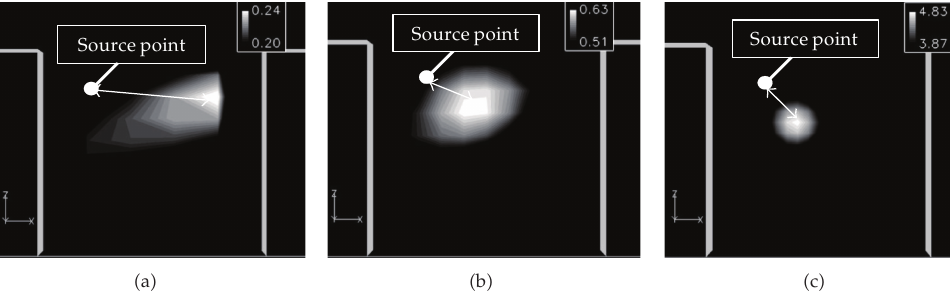
Figure 6: Peak concentration (cid:3) tU b /H b (cid:7) 200 (cid:4) : (cid:3) a (cid:4) Case 1-1, (cid:3) b (cid:4) Case 2-1, and (cid:3) c (cid:4) Case